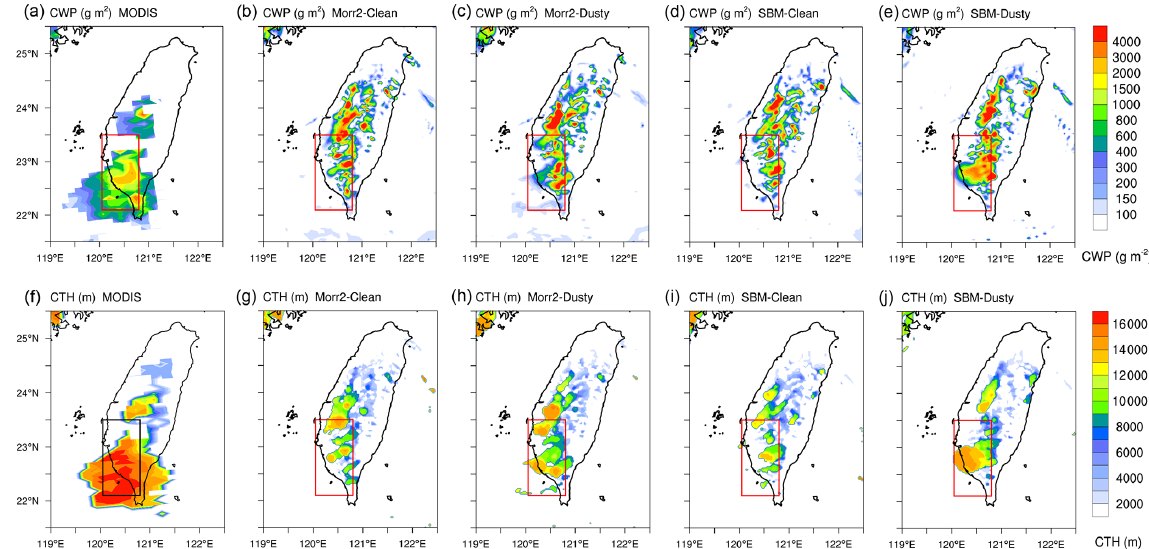
Figure 6. The cloud water path (CWP) at 14:00LT from (a) MODIS observation, (b) Morr2-Clean, (c) Morr2-Dusty, (d) SBM-Clean, and (e) SBM-Dusty simulations. Cloud top height (CTH) on grids with CWP larger than 100gm − 2 from (f) MODIS observation, (g) Morr2- Clean, (h) Morr2-Dusty, (i) SBM-Clean, and (j) SBM-Dusty